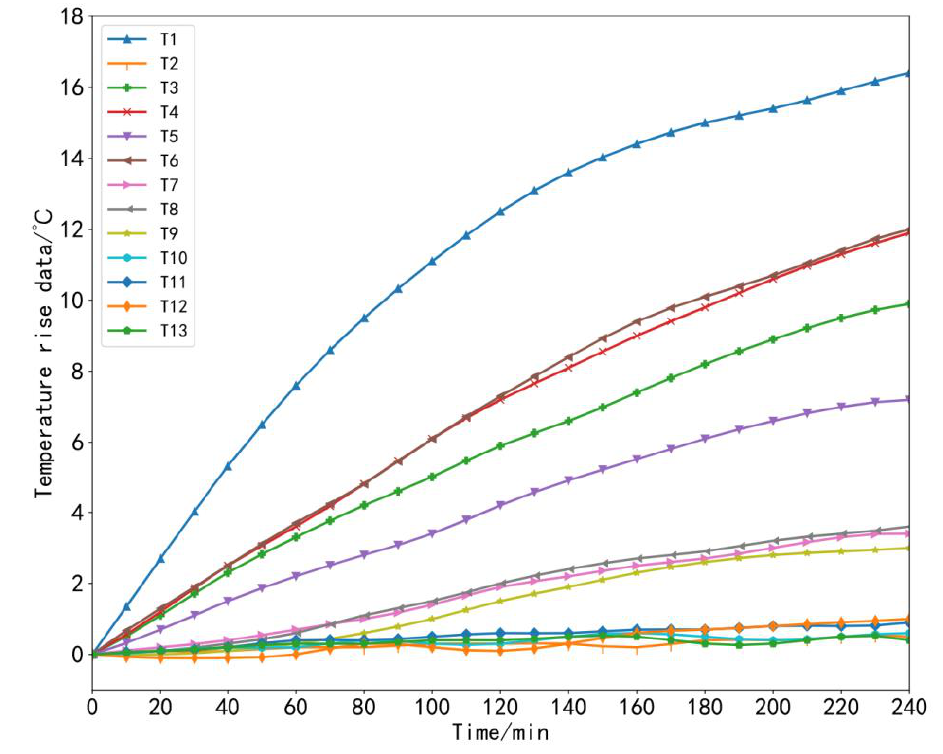
Figure 11. Temperature rise data at a speed of 8000 mm/min.